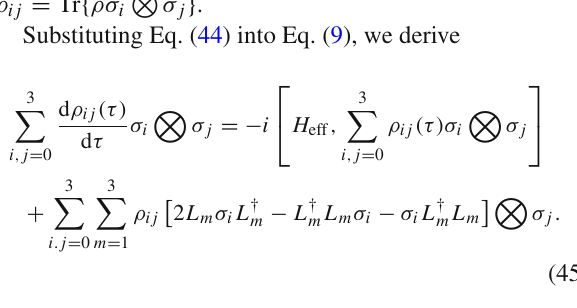
field. Therefore, this makes it easier for them to